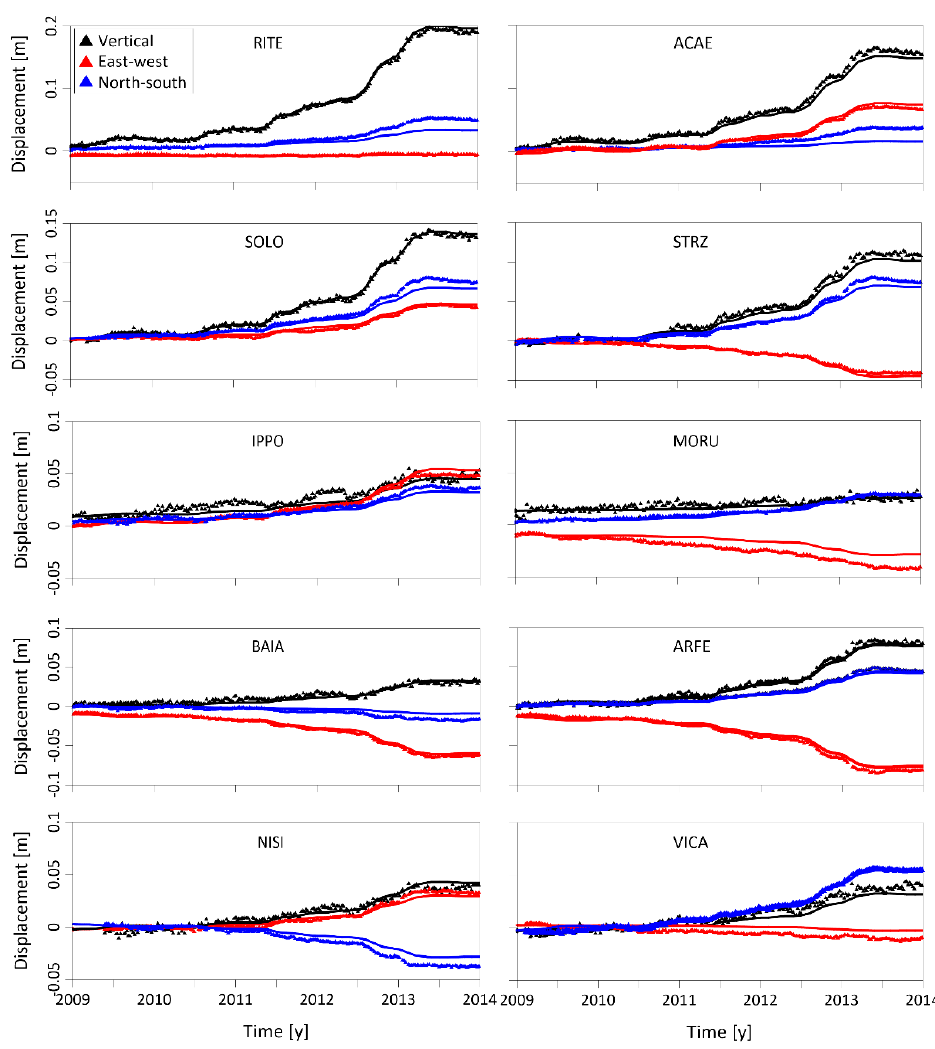
Figure 8. Time-dependent FE model results. The 2009–2013 cGPS displacement (RITE, ACAE, SOLO, STRZ, IPPO, MORU, BAIA, ARFE, NISI, VICA) time series of the three deformation components: vertical in black, east–west in red, and north–south in blue. All the measurements refer to MAFE station. The triangles are the data [11,17], while the continuous lines represent the time-dependent model results.